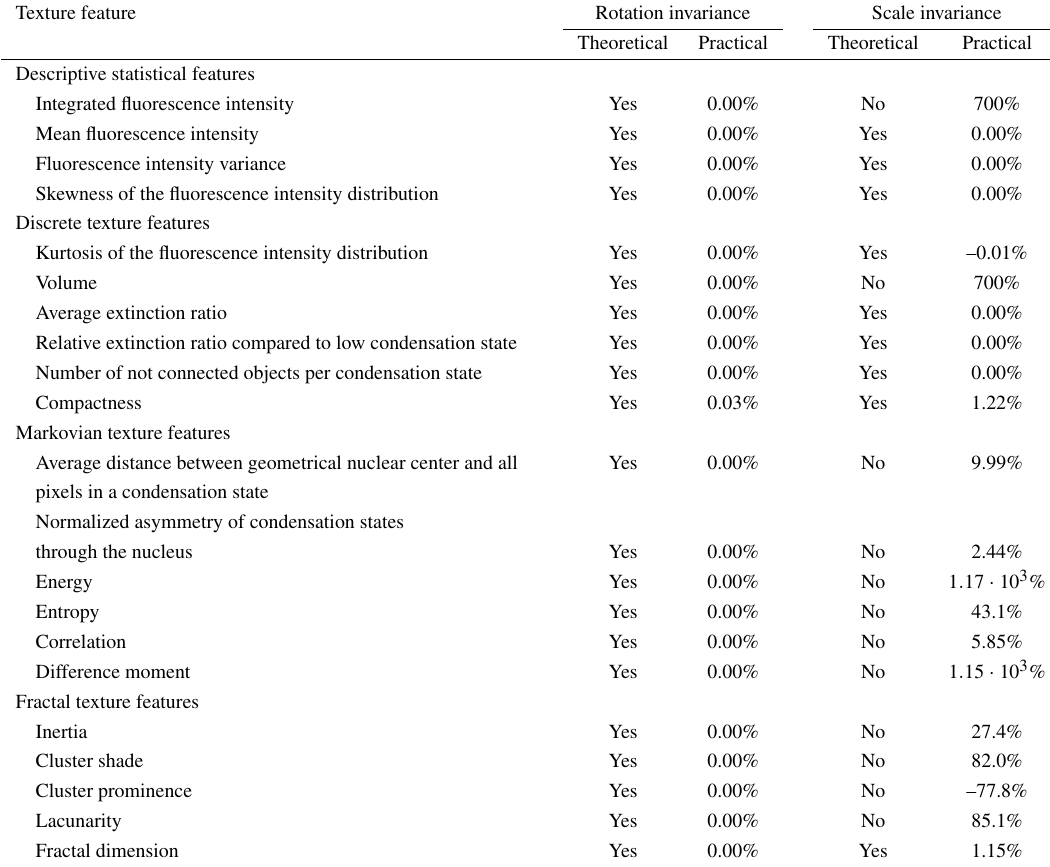
Invariance properties of 35 implemented 3D texture features computed on artificial nuclei having a nuclear size of 10 µ m and a nucleolar size of 3 µ m and a scaling of the central area with a low amount of DNA of 0.5 with respect to the nuclear size. The percentages are relative changes with respect to the initial image from which the rotated and scaled images were